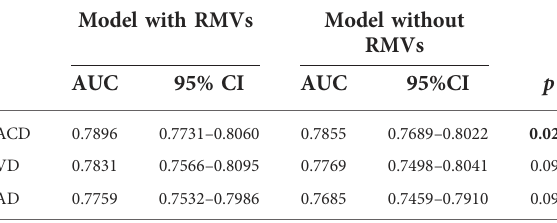
TABLE 3 AUC changes with inclusion of RVMs.